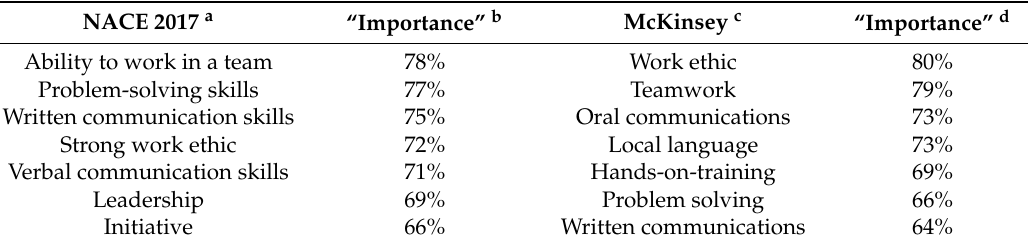
Table 1. Most important skills sought by